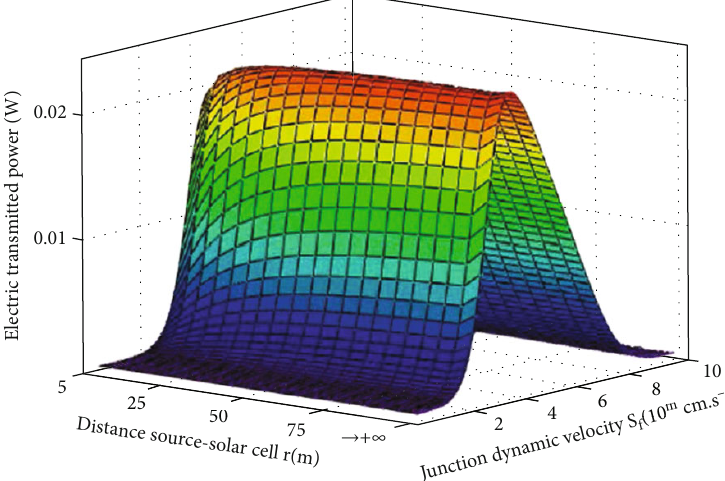
Figure 11: Transferred electric power versus junction dynamic velocity ( S